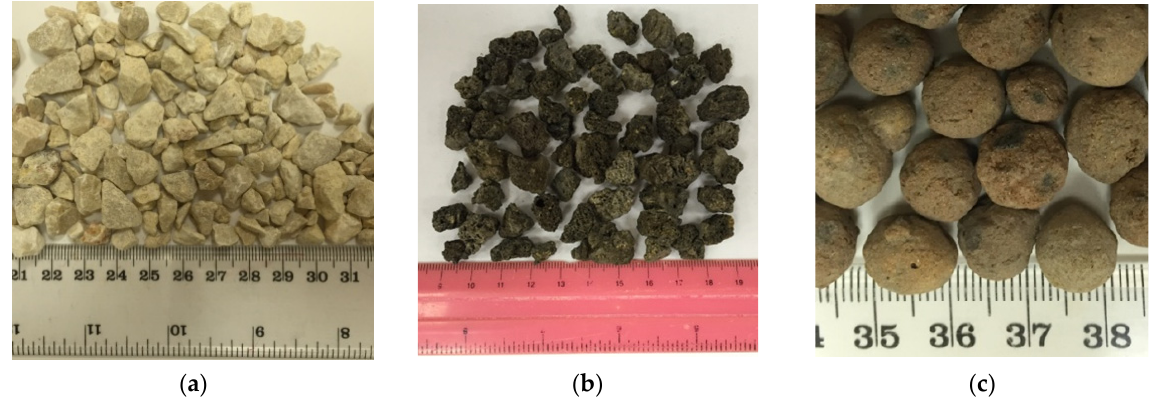
Figure 1. Reference coarse aggregates used: normal weight coarse aggregate (NCA) ( a ); volcanic lightweight coarse aggregate (VLA) ( b ) and lytag coarse aggregate (LYA) ( c ).